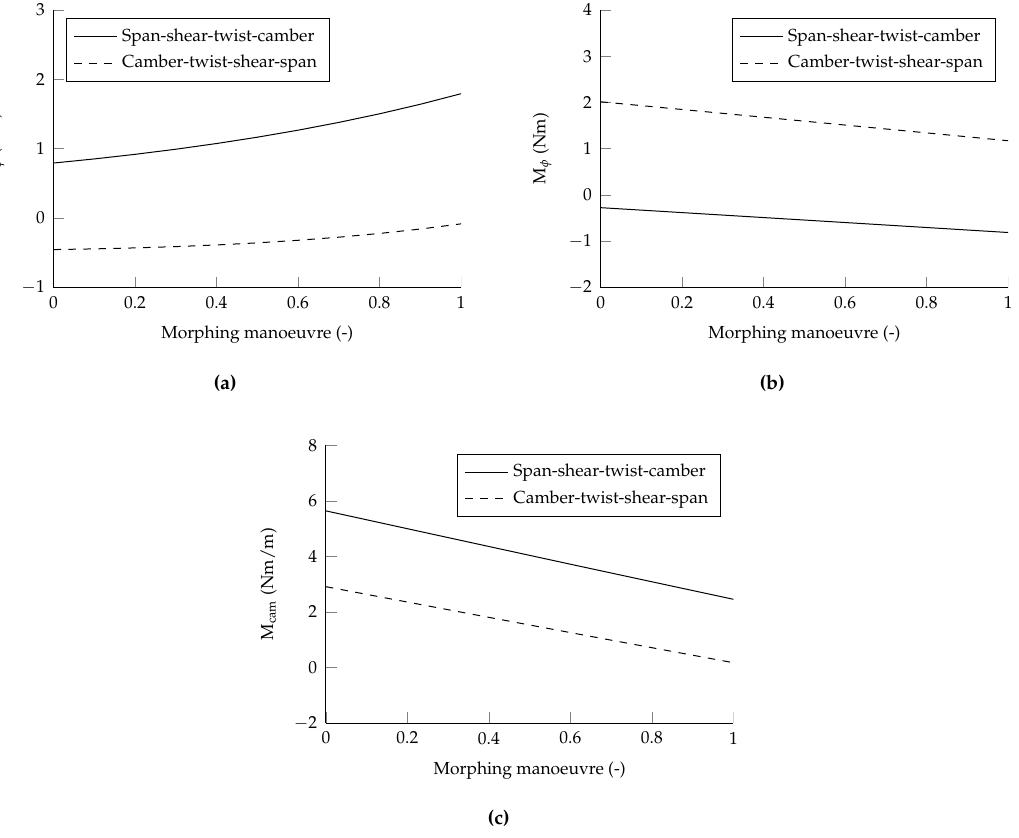
Figure 4. Effect of morphing scheduling on morphing actuator requirements. ( a ) Shear morphing moment of shear section 1; ( b ) Twist morphing moment; ( c ) Leading edge camber morphing moment at the wing